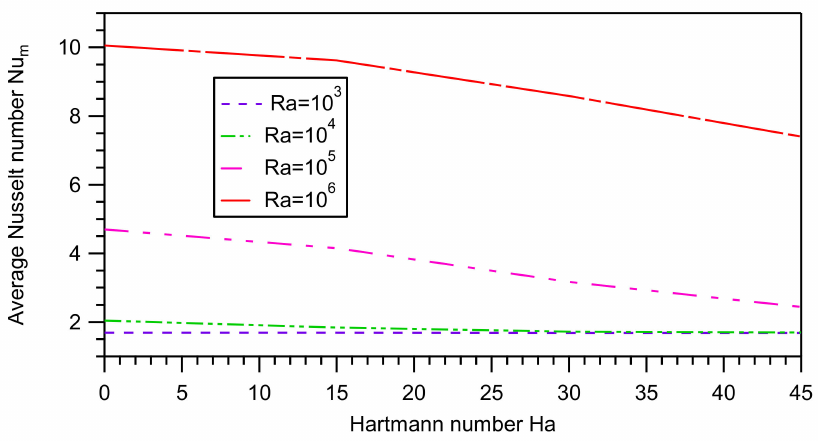
Figure 8. The average Nusselt number Nu m for different values of Rayleigh number (Ra = 10 3 , 10 4 , 10 5 and 10 6 ) with Da = 10 − 2 , AR = 0.3, ω = 0, ϕ = 0.04, Fr = 0.75 and q ∗ =